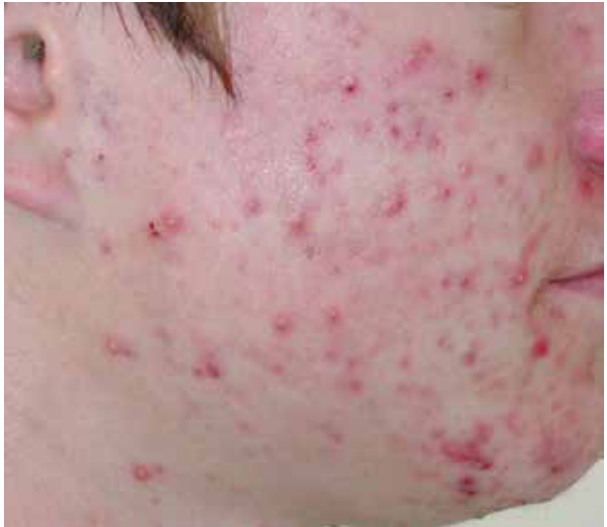
Picture 2: Inflammatory papules and small pustules